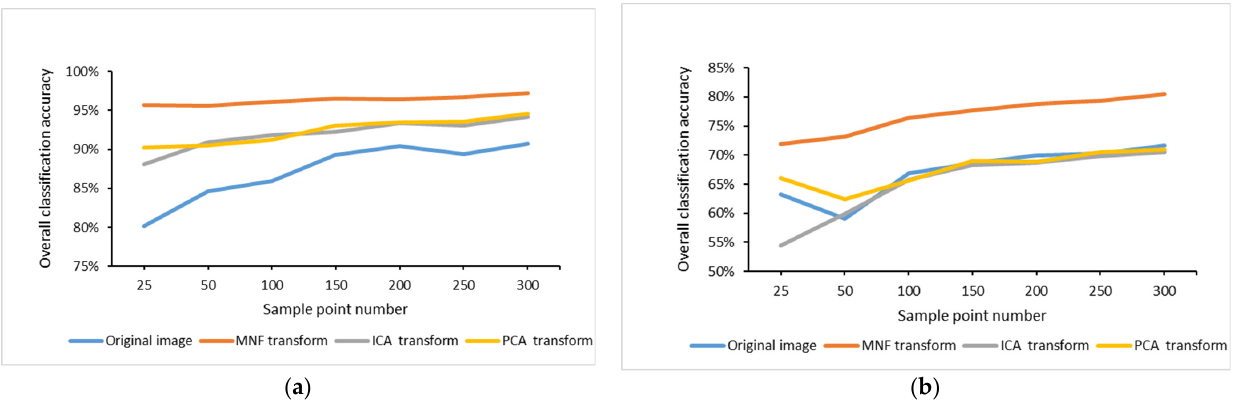
Figure 9. ( a ) The change of overall classification accuracy with the number of random sample points in the Longkou area; ( b ) the change of overall classification accuracy with the number of random sample points in the Honghu area.